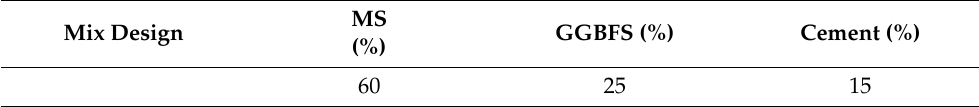
Table 3. Mix design used for the double-step cold-bonding